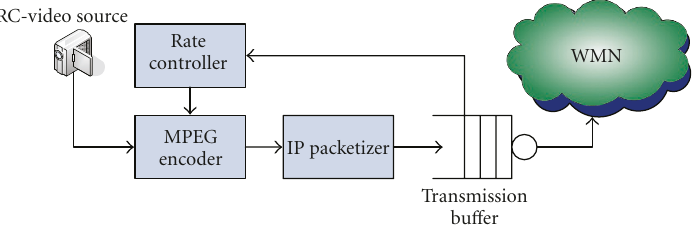
Figure 4: RC-video source